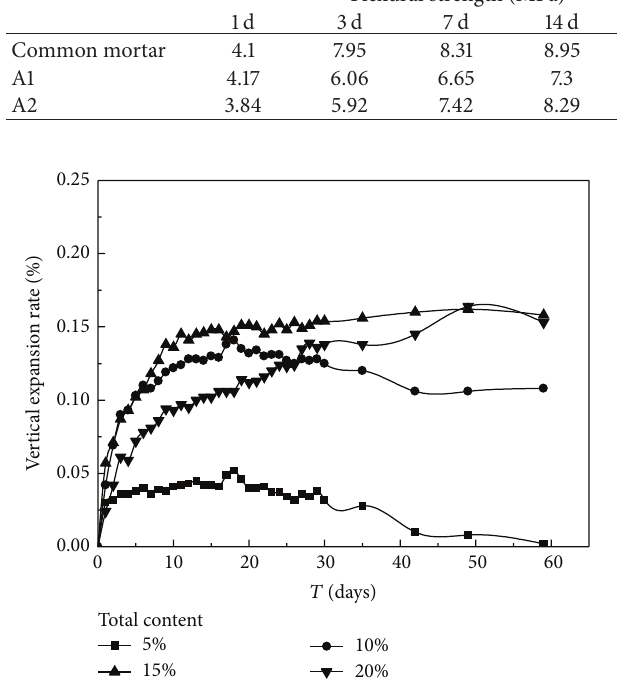
Figure 4: Effect of the total content on expansion rate ( 𝐾 = 1).